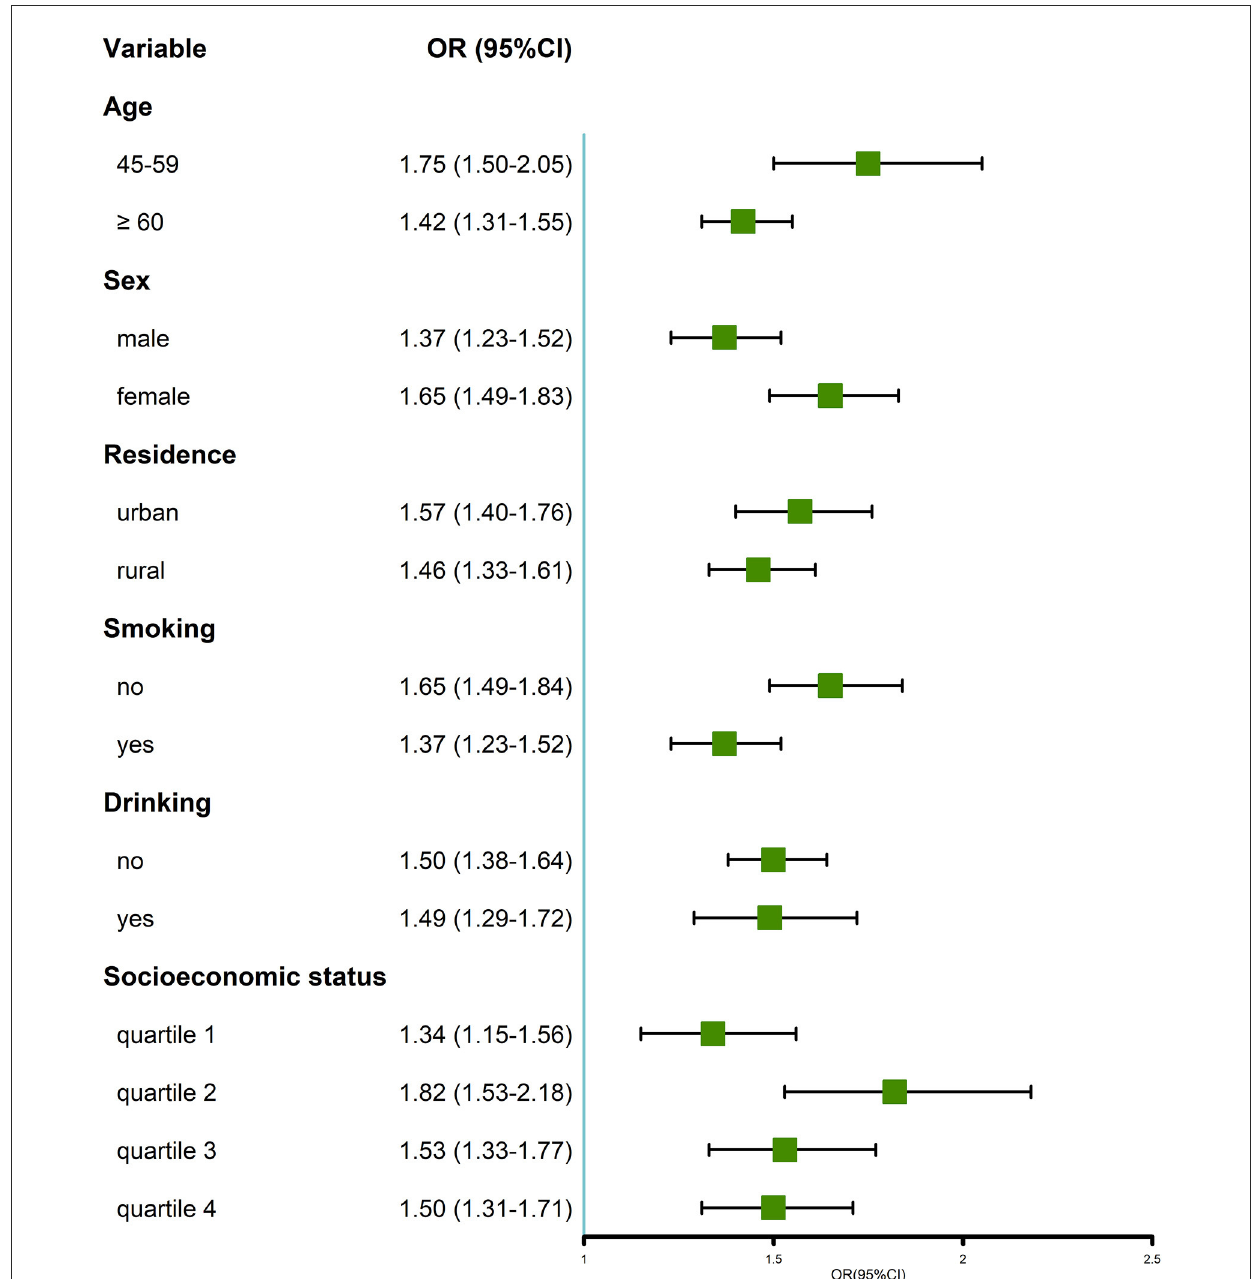
FIGURE3 Stratified analysis of the ORs between multimorbidity and memory-related diseases.